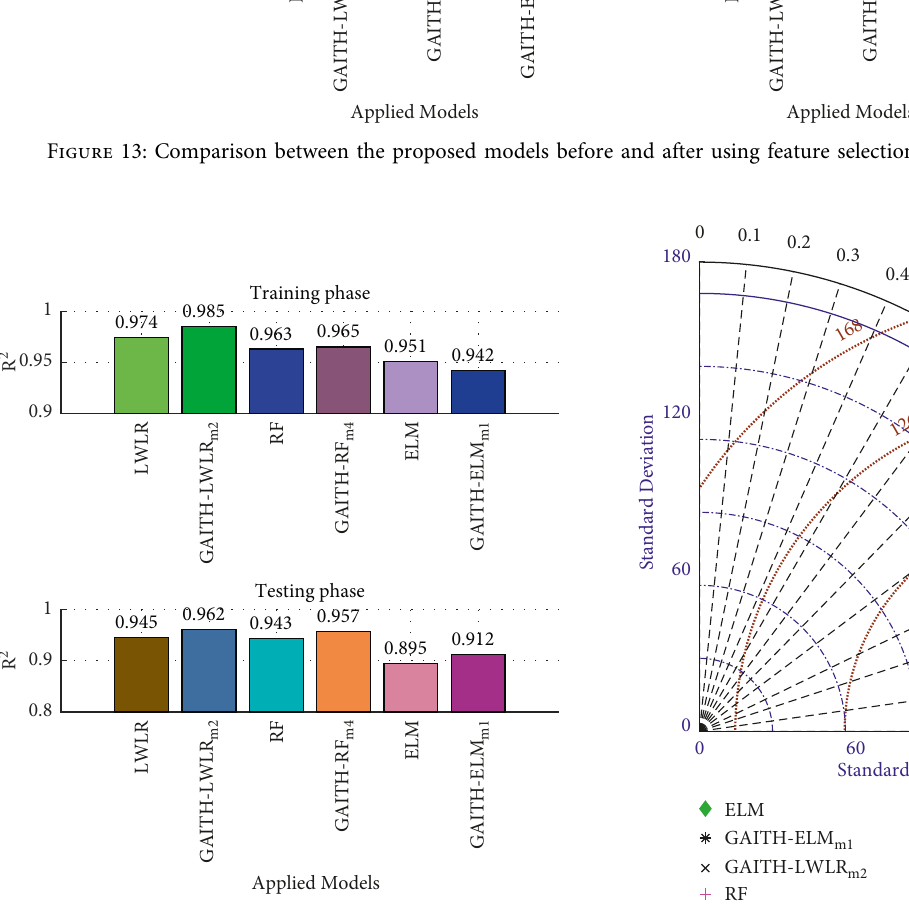
Figure 15: The Taylor diagram shows the improvement in pre- diction due to the presence of a feature selection algorithm: training